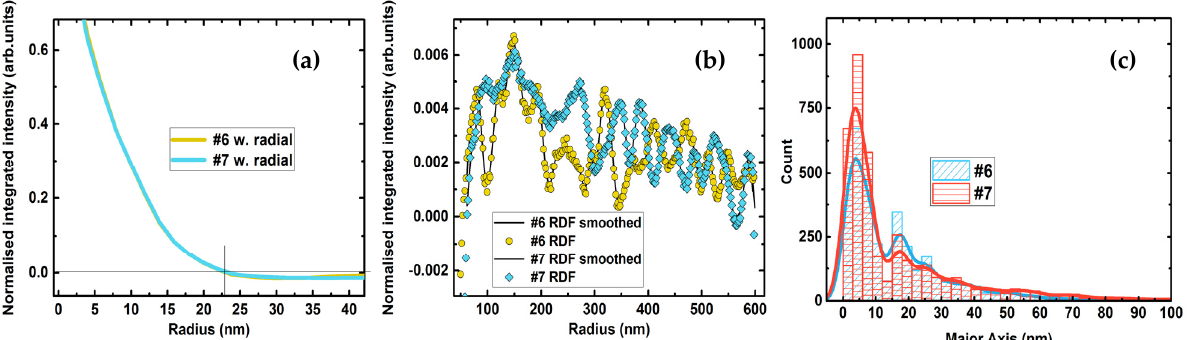
Figure 8. The radial average of the autocorrelation of pores from AFM images of the surface of Fe 3+ x Si 1 − x /Ge/Fe 3+ x Si 1 − x /Si(111) heterostructure. ( a ) The average pore size is close to 23 nm for both samples; ( b ) autocorrelated RDF for the samples #6 and #7 beyond the average pore size; and ( c ) distribution of pore size fitted with ellipses for the sample discussed.